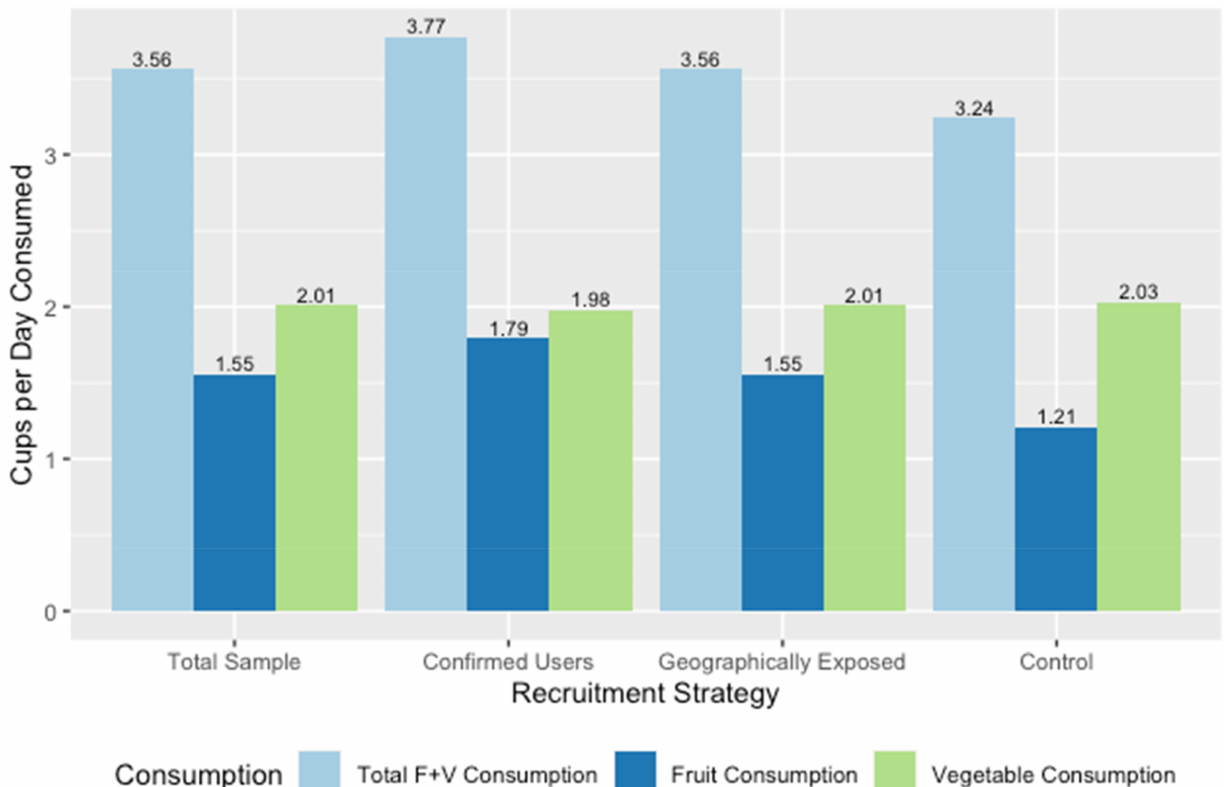
Figure 3. Average fruit and vegetable consumption in cups/day among adults at baseline by recruitment strategy (FRESH- Austin Evaluation study Austin, Texas, October 2018–March